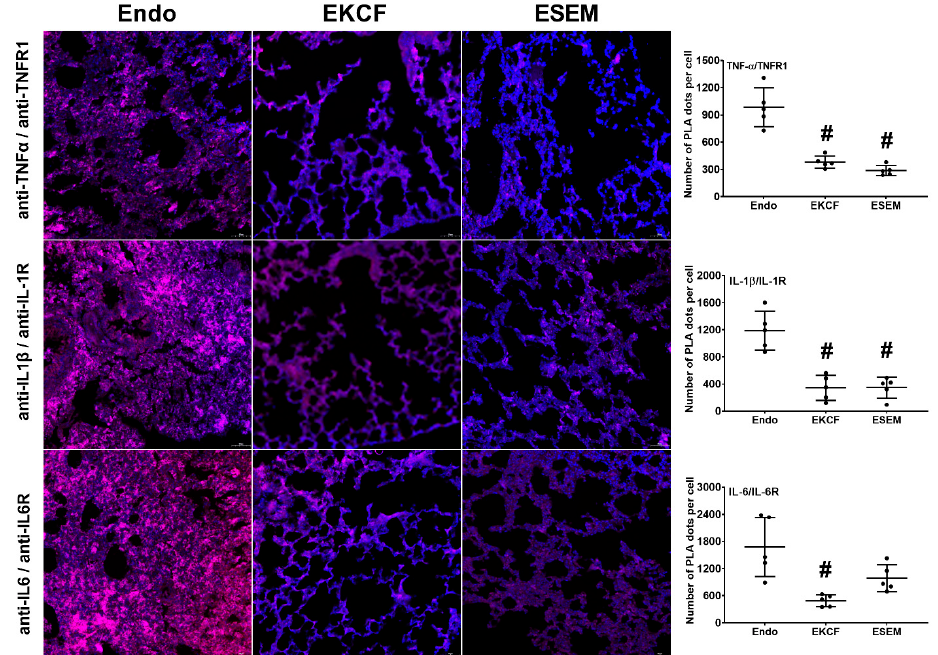
Figure 2. Cytokine-receptor binding status. Representative microscopic images of immunofluores- cence staining of proximity ligation assay (PLA) and PLA signal intensities for measuring bindings of tumor necrosis factor- α (TNF α ), interleukin-1 β (IL-1 β ), and interleukin-6 (IL-6) to the cognate receptor TNF receptor 1 (TNFR1), IL-1 receptor (IL-1R), and IL-6 receptor (IL-6R) in lung tissues in mice that were measured at 24 h after endotoxin administration. Red dots: (+) PLA signal, indicating (+) protein–protein interactions between TNF- α /TNFR1, IL-1 β /IL-1R, and IL-6/IL-6R. Blue dots: 4 ′ ,6-diamidino-2-phenylindole stain, indicating a cell nucleus in lung tissues. Endo: the endotoxin group. EKCF: the endotoxin plus the KCF18 peptide group. ESEM: the endotoxin plus the SEM18 peptide group. Data were obtained from five mice in each group and presented as the mean ± standard deviation. # p < 0.05, versus the Endo group.